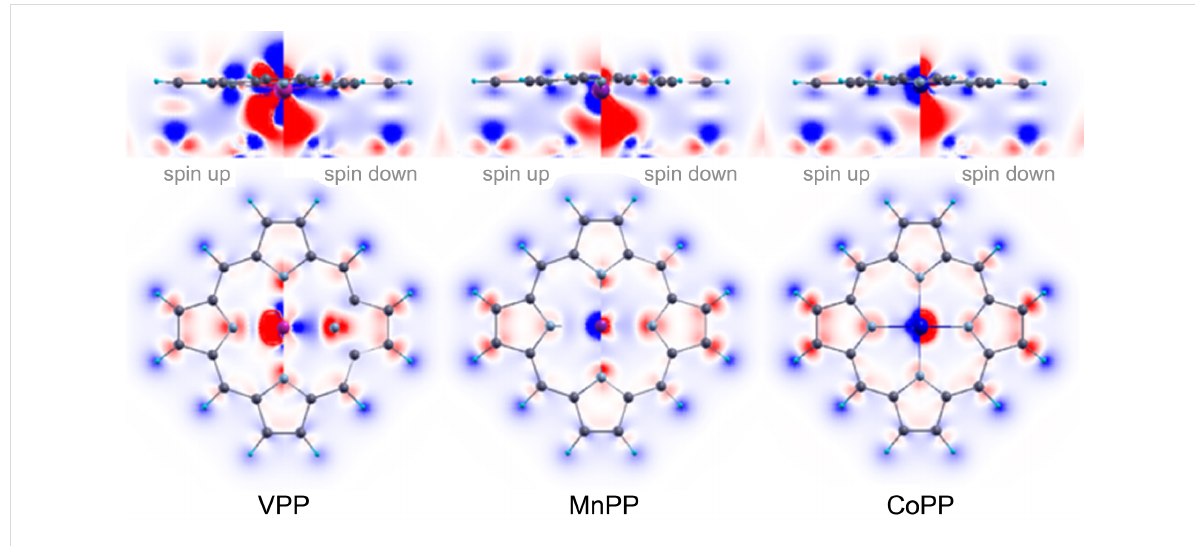
Figure 5: The values of for selected TMPP systems (M = V, Mn, Co; red: positive values, blue: negative values). Min/max values ±0.0015 e /bohr 3 . We use two perpendicular planes to plot the figures, i.e., the plane including the atoms of TMPP (bottom) and the plane perpendicu- lar to it, including the TM atom (top). Details for spin-up and spin-down are presented in each half of the three images.